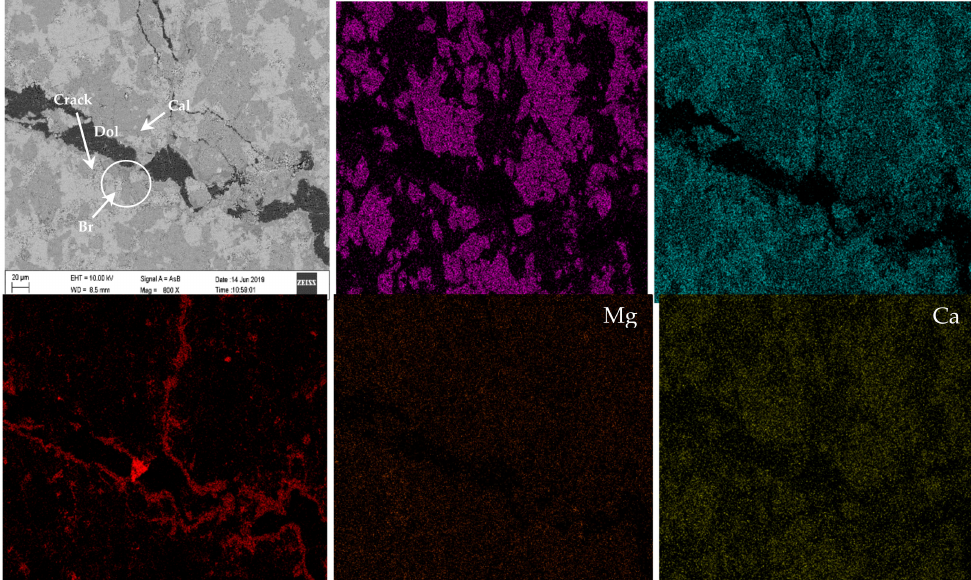
Figure 14. Element mapping of the RILEM AAR-5 concrete bars. ( A – F ): Concrete microbars made with the dolomitic BFL1 aggregate in TMAH at 80 ◦ C after 196 d. ( A ) SEM photograph; ( B ) Mg in the spotted brucite and dolomite; ( C ) Ca in the spotted calcite and dolomite; ( D ) Si images; ( E , F ) Na, K images.